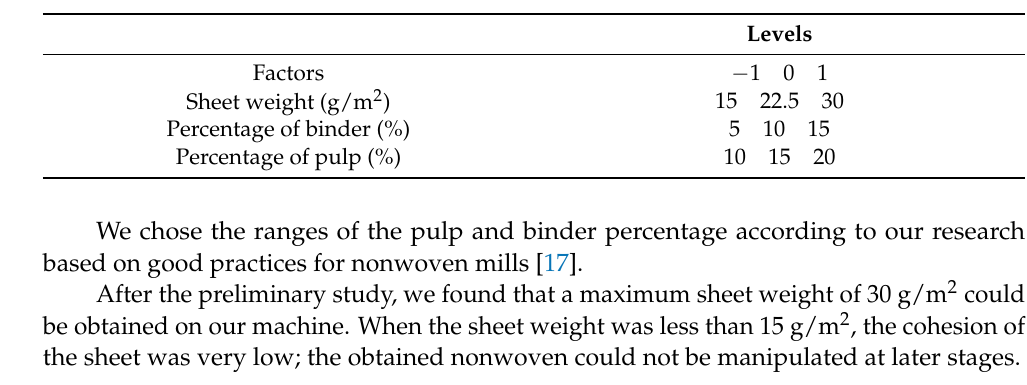
Table 2. Levels of the Box–Behnken